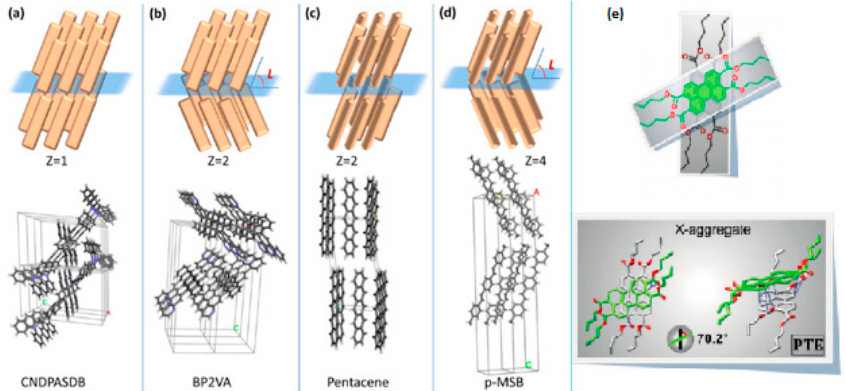
Figure 2. ( a – d ). Schematic representation of molecular packings. Reproduced with permission from ref. 50. Copyright 2014, Wiley-VCH. ( e ) Schematic representation of X-aggregate of PTE molecule. Reproduced with permission from ref. [48]. Copyright 2018, Wiley-VCH.